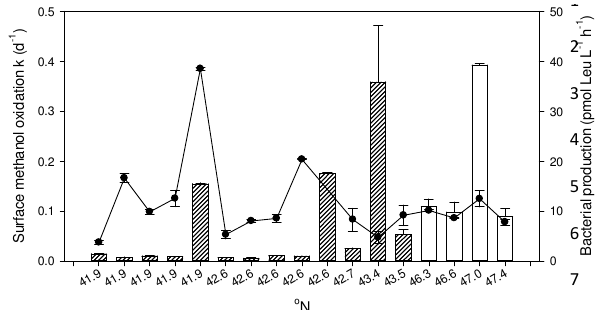
Fig. 6. (a) Spatial variability in methanol oxidation (apparent rate constant, k) in surface (2–10m) waters with corresponding bacte- rial leucine uptake. The hashed bars indicate methanol oxidation with surface concentrations < 0.2µgl − 1 (41–43 ◦ N), and the open bars chlorophyll a between 0.3–0.6µgl − 1 (46–47 ◦ N). Error bars are based on at least 3 replicates.